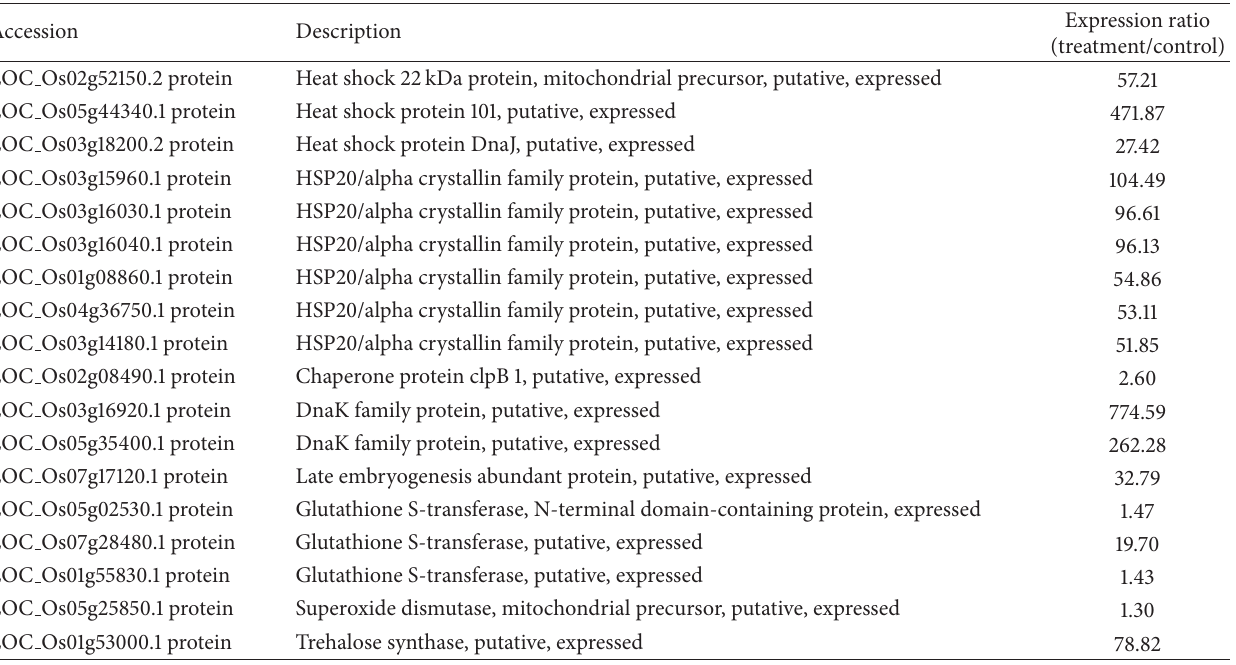
Table 2: Upregulated rice anther protein against heat